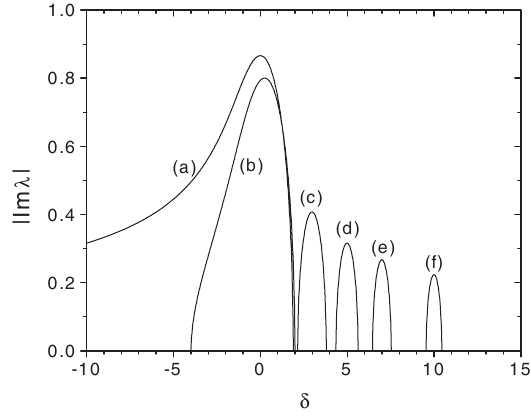
FIG. 1. Imaginary part of the complex root of the cubic Eq. (13) vs (cid:5) for 1 = 2 (cid:1) (cid:1) equal to 0 (a), 0 : 5 (b), 3 (c), 5 (d), 7 (e), and 10